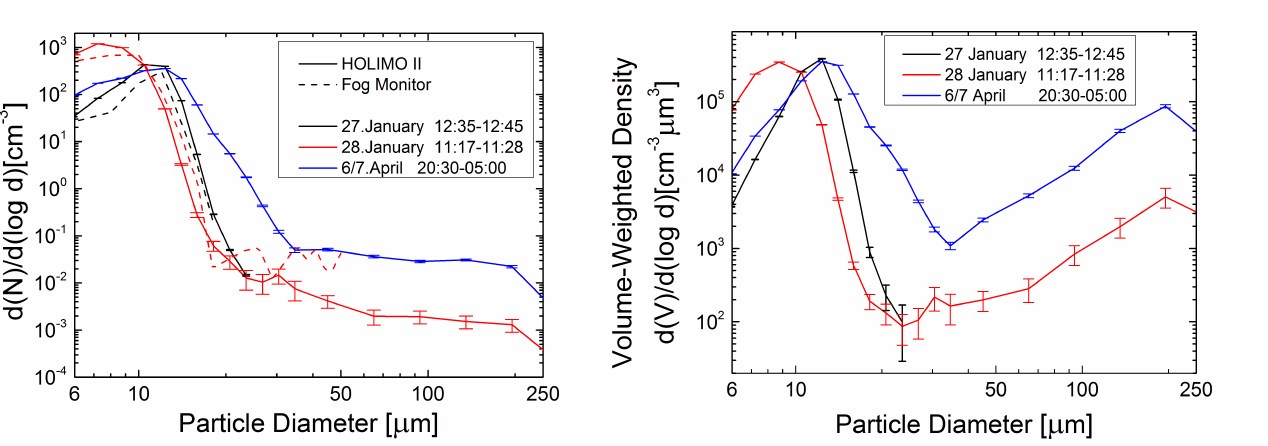
Fig. 7. Cloud particle-number distribution measured by HOLIMOII (solid) and the fog monitor (dashed) during January/April 2012 at Jungfraujoch. The error bars are for one standard deviation, assum- ing Poisson counting statistics.